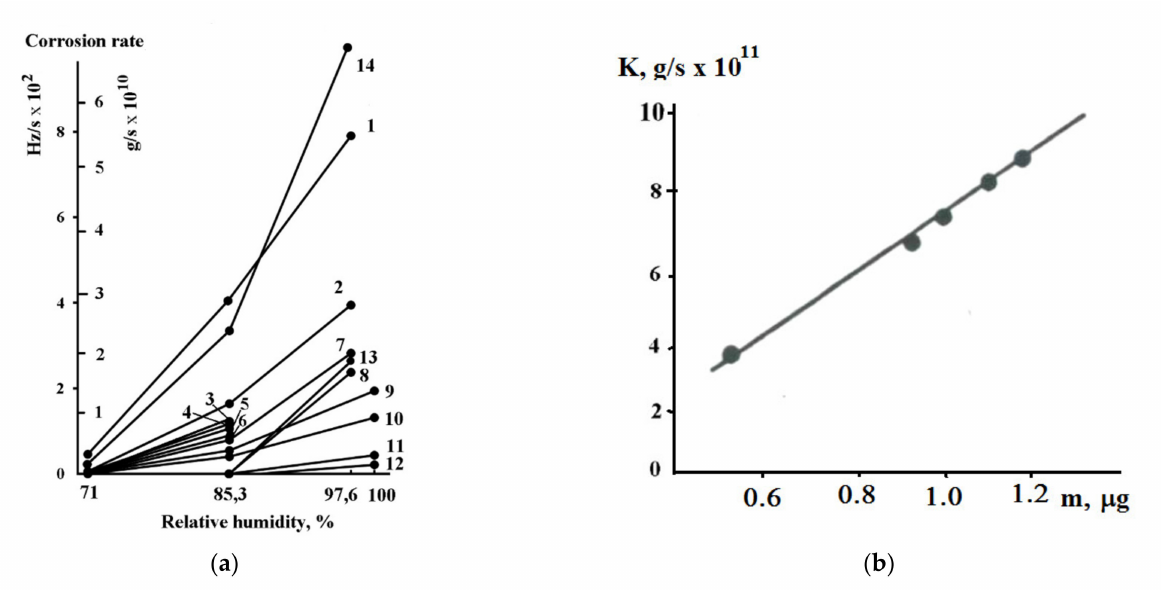
Figure 12. ( a )—QCM measurements of iron corrosion rate in the air of different humidity with grafted thin siloxane films; 1—bare iron, 2–6, 9, 10 thin BTMS films of 6–12 monolayers; 7, 8, 13—one monolayer MTMS films; 11, 12—MTMS films 3 and 6 monolayers, 14—BTMS 18 monolayers. ( b )—Fe corrosion rate vs. water adsorption in the air at 85.3% RH [21]. Published with permission from NAUKA/INTERPERIODIKA